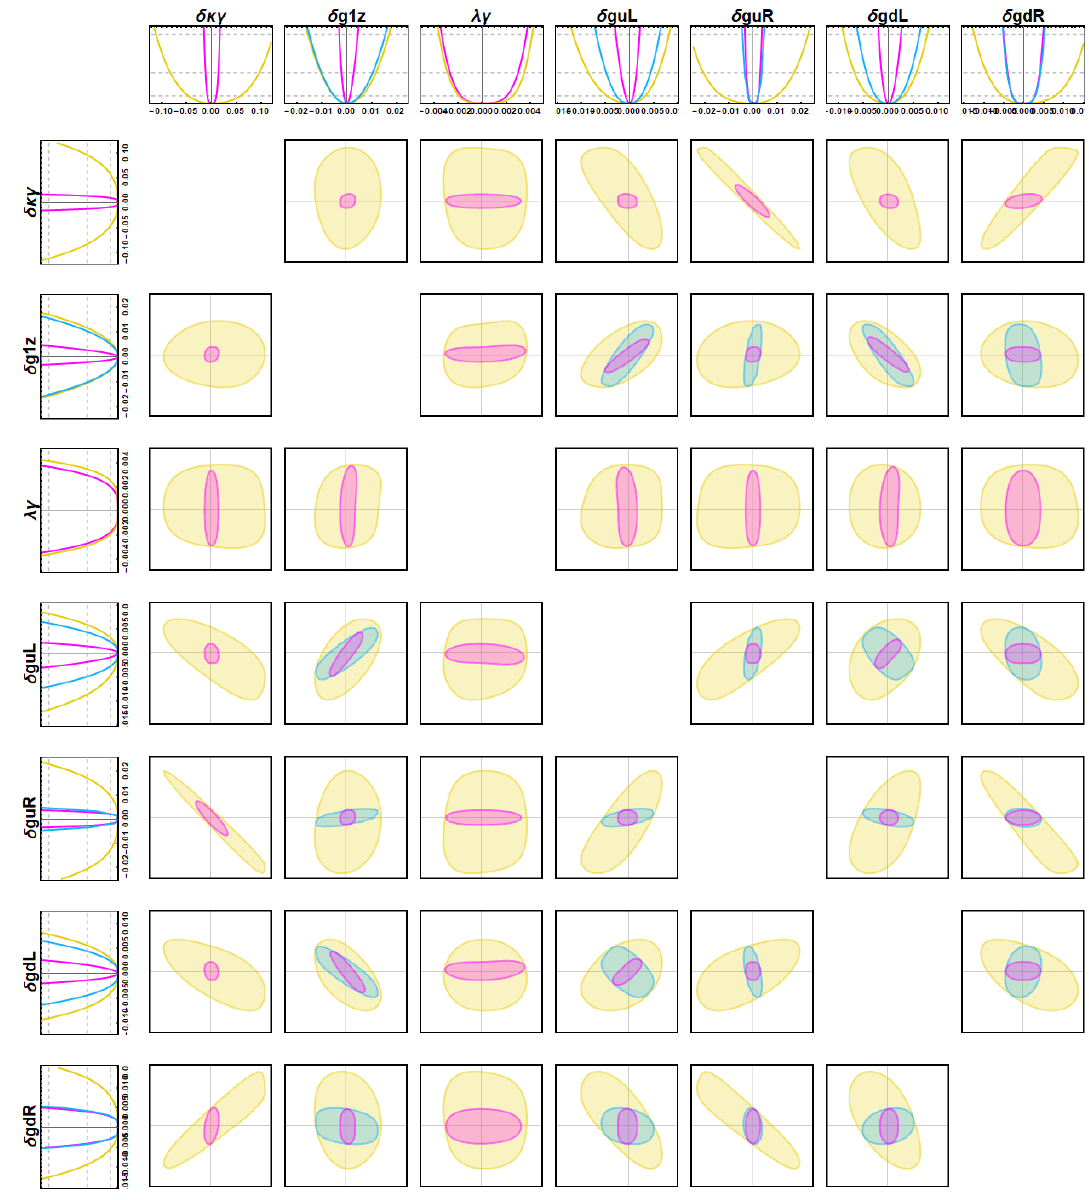
Figure 13 . One and two dimensional 95% CL constraints for the seven parameters entering in diboson processes, using the pp ! W + W (cid:0) and pp ! WZ projections for 13 TeV with 3 ab (cid:0) 1 of integrated luminosity and assuming a 10% systematic uncertainty. In yellow, all parameters are pro(cid:12)led. In blue, we pro(cid:12)le over all parameters but setting (cid:14)(cid:20) (cid:13) = (cid:21) (cid:13) = 0. In pink, we do an exclusive (cid:12)t setting to zero all parameters not appearing in the plot labels.